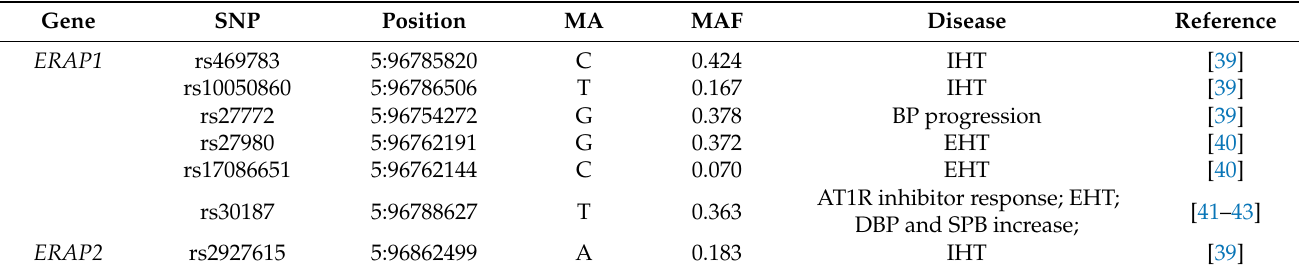
Table 1. ERAP1 and ERAP2 polymorphisms associated with BP dysregulation.